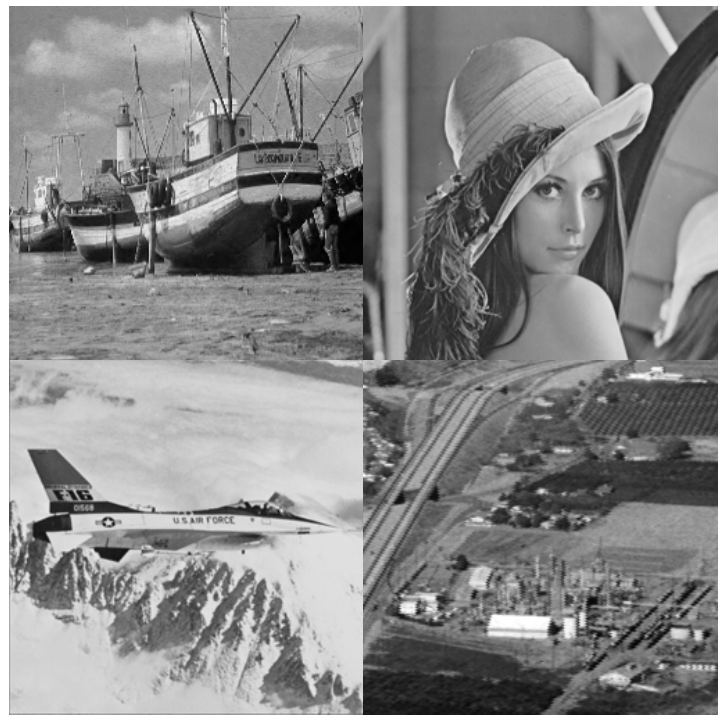
Figure 2. Four of the test images from Computer Vision Group, University of Granada (CVG-UGR) image database [41].